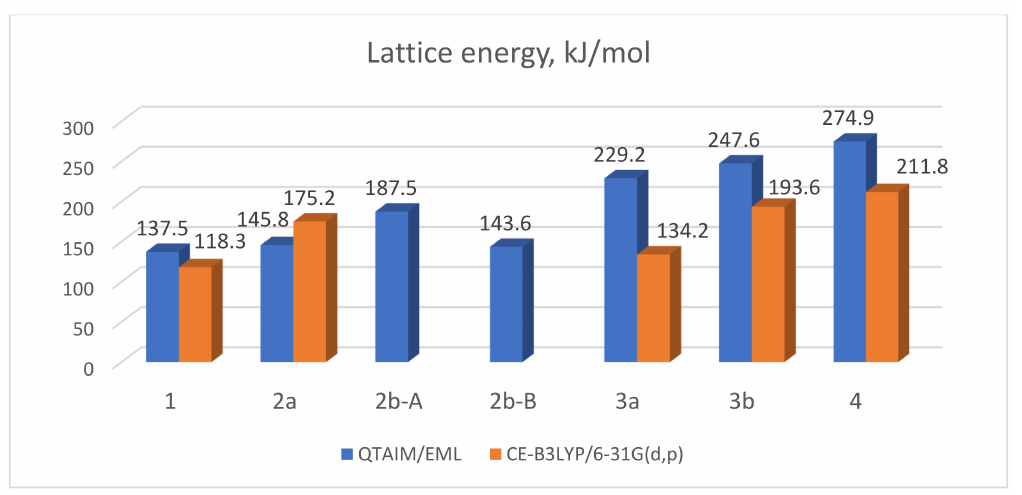
Figure 13. Calculated lattice energies in 1 – 4 . The values are shown above the bars. Molecules A and B denoted as 2b -A and 2b -B. The values were multiplied by